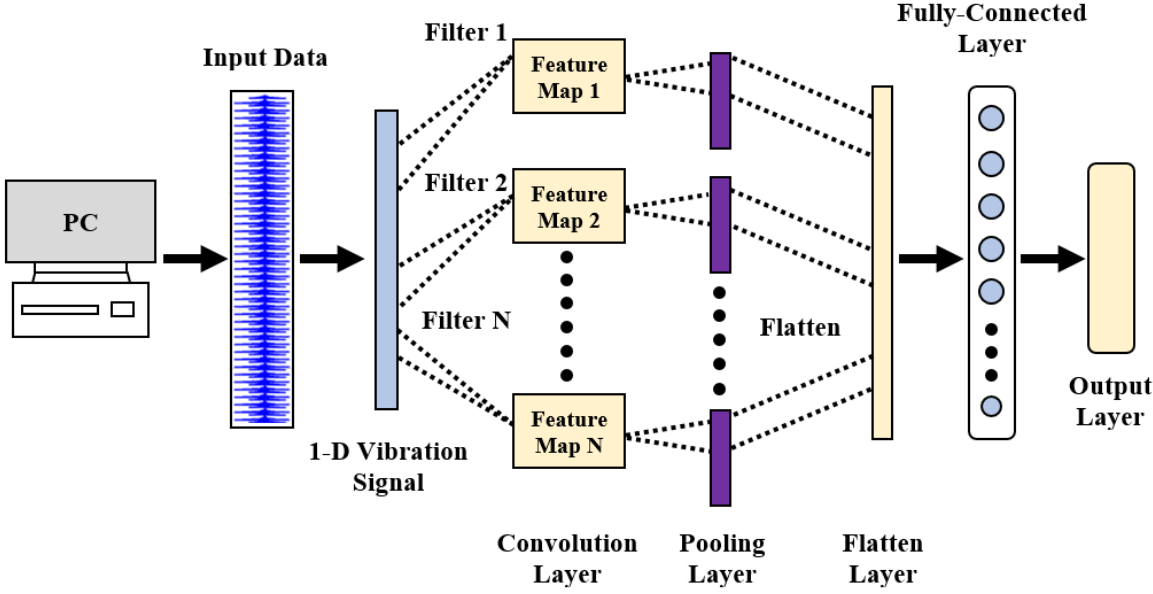
Figure 4. A depiction of 1-D CNN architecture. The present study developed a 1-D CNN model to classify different health conditions, namely, (1) healthy state, (2) 25% crack level, (3) 50% crack level, (4) 75% crack level,